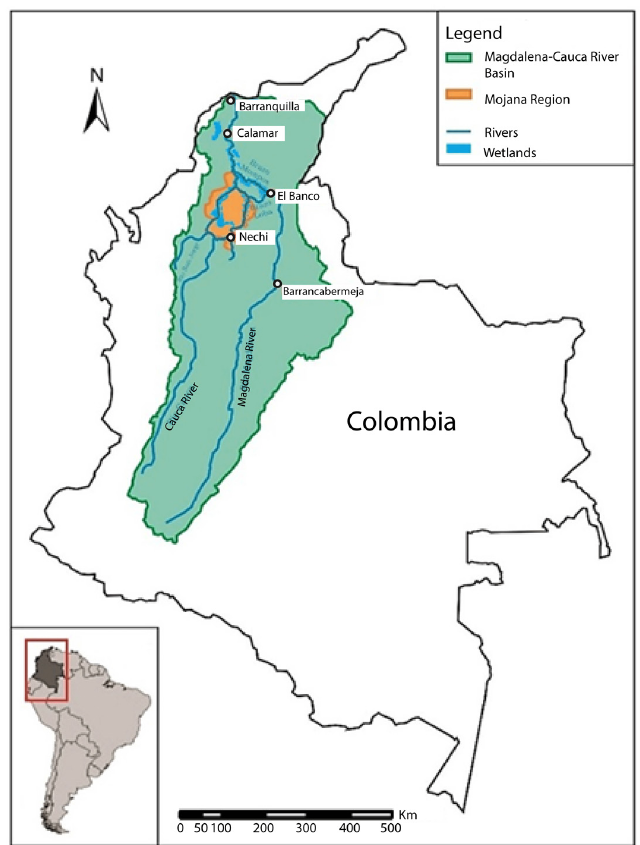
Figure 3. Location of the Magdalena River basin (Colombia). In orange the Mompox depression (including the Mojana) characterized by a dense presence of large wetlands.